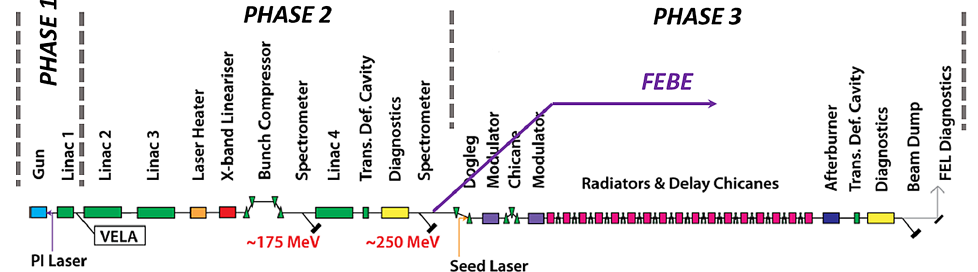
FIG. 1. Schematic of the full CLARA facility showing different phases in which CLARA is being built and the low-energy beam line (merging with VELA) as well as high-energy (FEBE) beam line. The total length of the facility is ≈ 90 m.